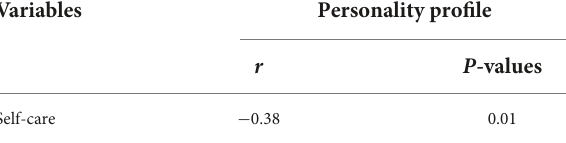
TABLE 3 Relationship between self-care status and personality profile of patients with type 2 diabetes. Variables Personality